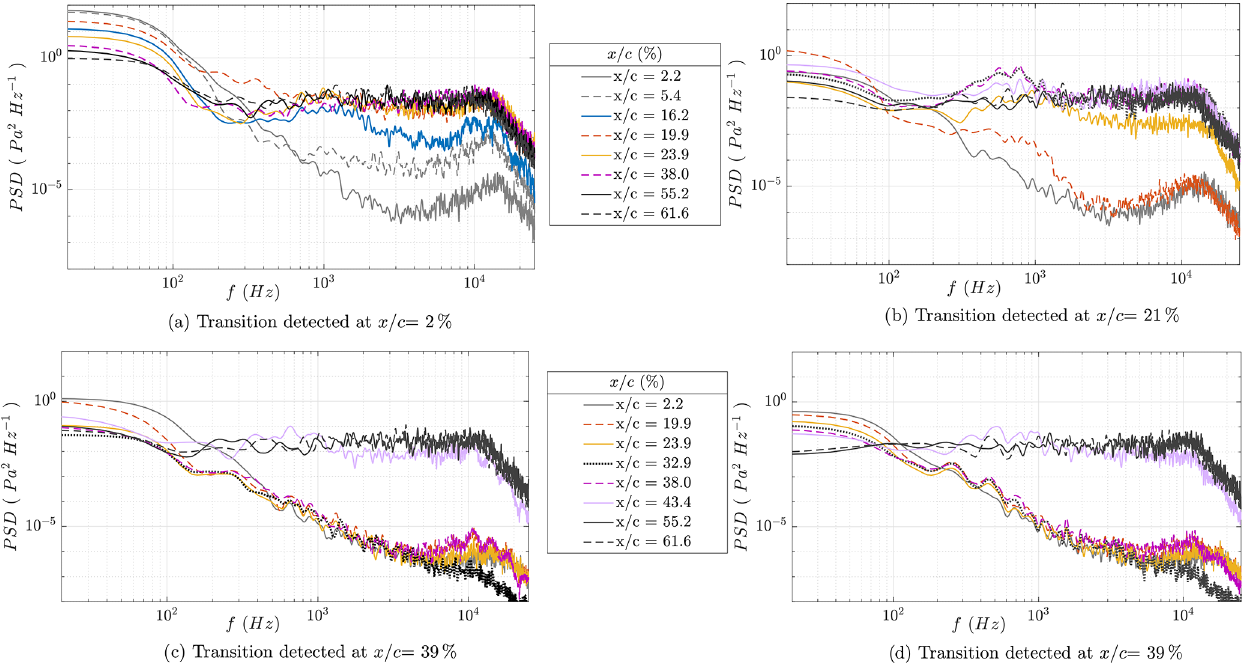
Figure 6. PSD at various x/c positions at different time indices (corresponding to the points a, b, c, d shown at Fig. 5) during a single revolution where the transition is detected at the chordwise location of (a) x/c = 2%, (b) x/c = 21%, and (c) x/c = 39%.